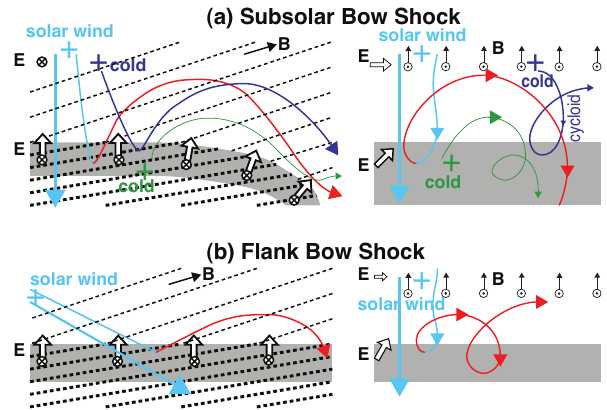
Fig. 10. Schematic illustration of ion motions just outside a quasi- perpendicular bow shock (grey area) with a finite magnetic field component normal to the shock surface. (a) Subsolar bow shock where the curvature of the bow shock cannot be ignored. (b) Flank bow shock where the reflection direction can easily be field-aligned. Left panels show the projection of ion trajectories onto a plane which contains the IMF ( B ) and solar wind, and right panels show the projection of the same ions onto a plane that is perpendicular to the left panel’s plane (depicting gyro-cycloid motions). Reflection of ions at the bow shock, which is due to the combination of out- ward electric field and change of the magnetic field, is assumed to be nearly specular. Note that a specular reflection is impossible in simple 1-D shock models with DC electric and magnetic fields ob- served at the Earth, and hence, the ion motion inside the bow shock is an open question. With this limitation, three types of source ions are illustrated. If an incoming ion is specularly reflected, the ion en- ergy is conserved in the bow shock reference frame, but it increases in the solar wind reference frame, resulting in a shift of the guiding center in the interplanetary electric field direction. The particle’s energy gain is proportional to the gyroradius, which is proportional to the guiding center velocity. A local ion from inside the shock ramp (green line) gains V k by electrostatic acceleration across the shock. A newly ionized exospheric neutral (blue lines) has zero field-aligned velocity in the planetary frame. Since the incoming so- lar wind (light blue lines) has a large angle with respect to the IMF for a quasi-perpendicular shock, conversion of the incident flow to the field-aligned direction by specular reflection is more prevalent along the frank (b) than near the subsolar region (a) . The flank is also favorable for multiple bouncing (i.e., multiple accelerations to higher energy) because of less